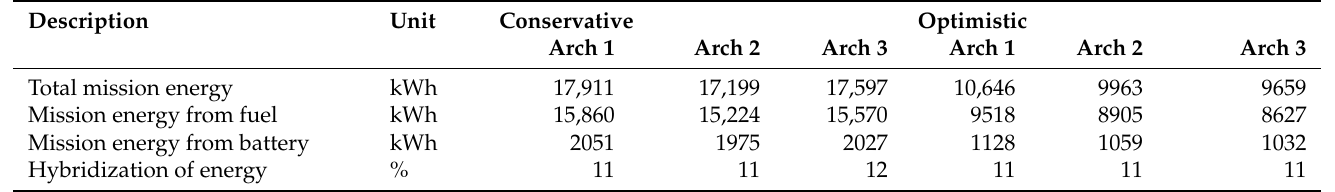
Table A4. Results on energy from the initial sizing for Architectures